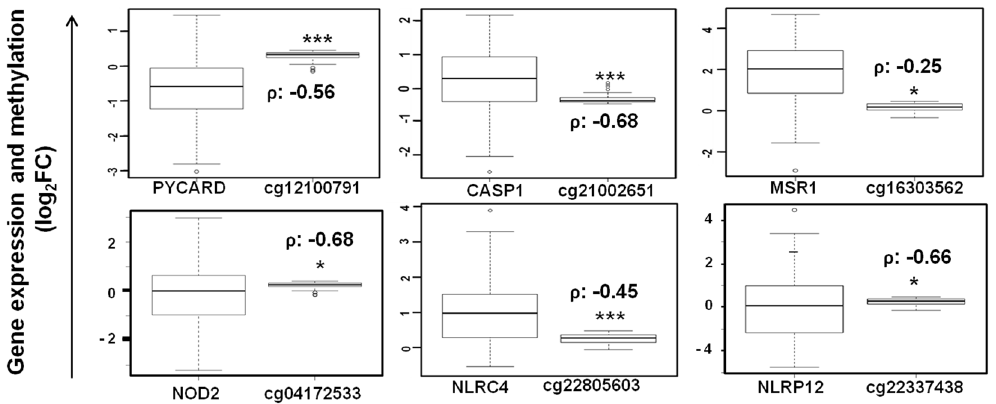
Figure 5. Negative regulation of NLR gene expression by methylation in Glioma. The box plots show significant inverse correlation between expression of NLRs and NLR -associated genes and differential methylation levels. Here, ρ denotes correlation coefficient calculated by the Pearson’s correlation